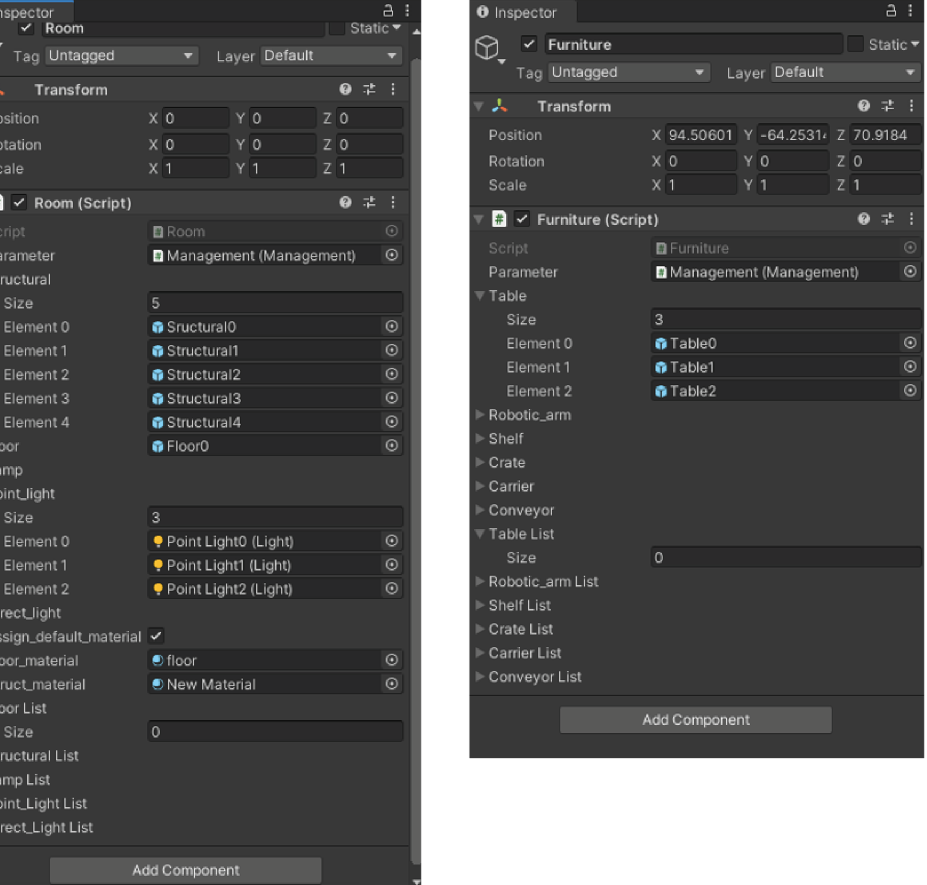
Figure 7. “Inspector” panel for Room ( left ) and Furniture ( right ) GameObjects in the 3D